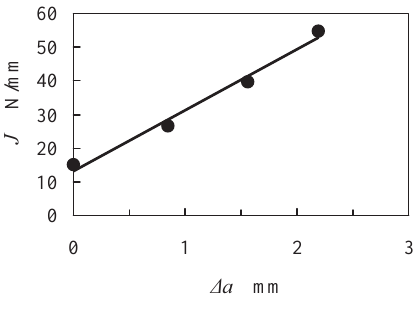
Fig.6. J-R curve of step cooled (SC) material at 313 K (40 (cid:864)